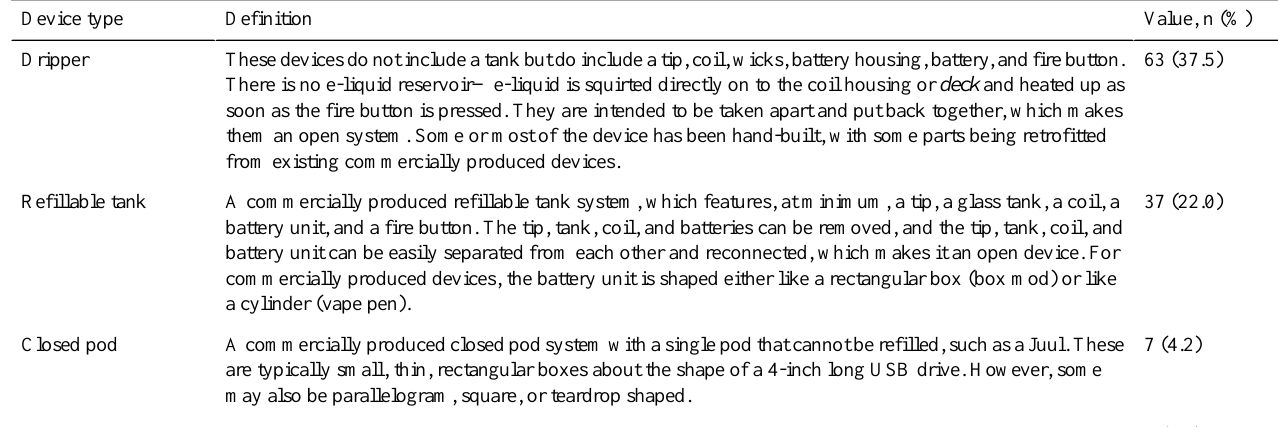
Table 1. Content codes for electronic nicotine delivery systems devices (N=168) and the percentage and number of videos in the final sample that featured each device